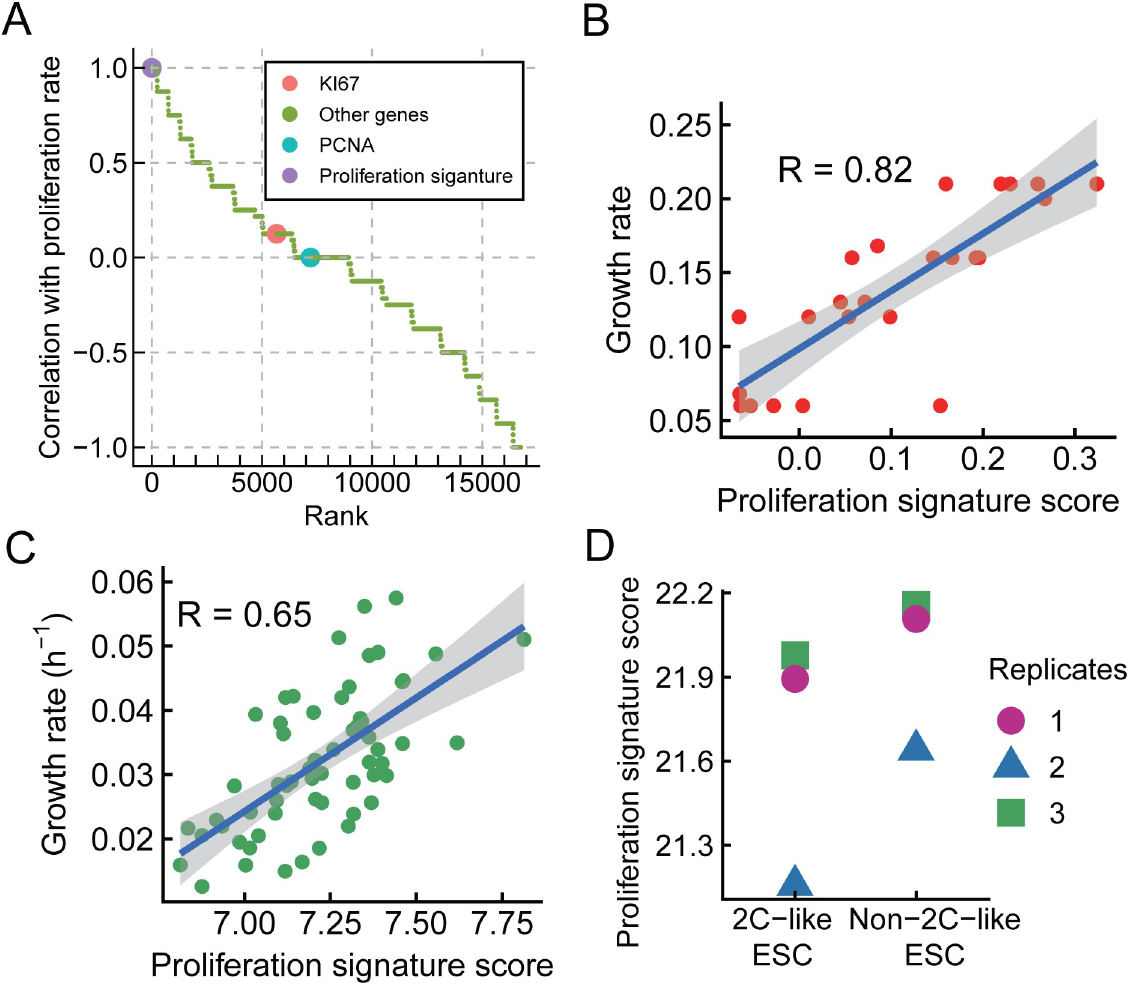
Fig 4. A proliferation signature model can predict relative growth rates from gene expression for species and cell-types on which it was not trained. (A) Genes and proliferation signature spearman correlation with proliferation rate (sorted by CFSE). Compare with KI67 or PCNA, proliferation signature has a better correlation with proliferation rate. (B) Using the proliferation signature to predict growth rate in budding yeast, we apply ssGSEA to calculate the enrichment score of proliferation signature for each sample. The Pearson correlation of proliferation signature score with growth rate is 0.82 (p = 8.9 × 10 − 7 ), the grey shading is a 95% confidence band. (C) Using the proliferation signature to predict growth rate in cancer cell lines, the Pearson correlation is 0.65 (p = 1.9 × 10 − 8 ), the grey shading is a 95% confidence band. (D) Comparison of proliferation signature score between 2C-like ESC and non-2C-like ESC (paired t-test, p = 0.04669).